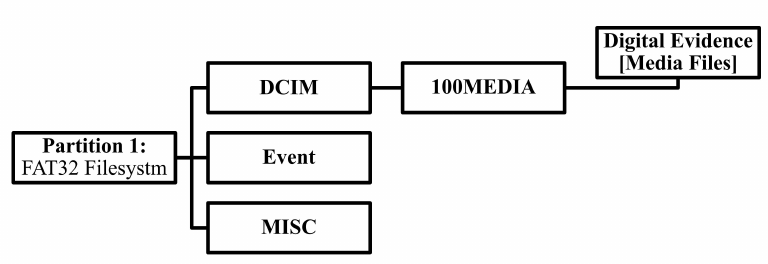
Figure 2. File system structure on the SD card of the Typhoon H camera.